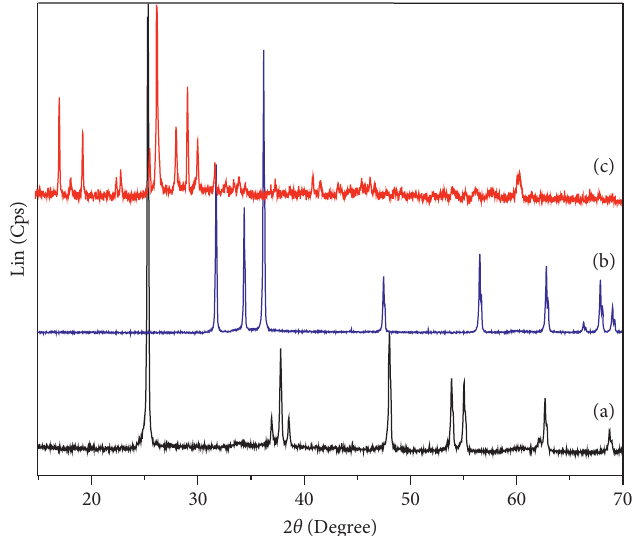
Figure 7: XRD patterns of recovered Ni-X catalysts after 3 runs: (a) Ni-TiO